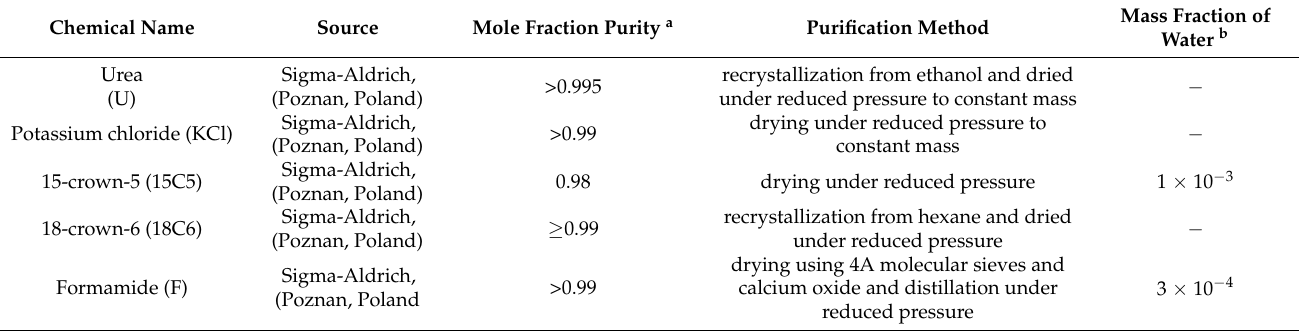
Figure 5. Dependence of the mole fraction of formamide in the solvation sphere ( y F ) of cyclic ethers: ■ , 1,4-dioxane; ● , 12C4; ▲ , 15C5; ▼ , 18C6, as a function of the mole fraction of formamide ( x F ) in the mixture F + W at 298.15 K.